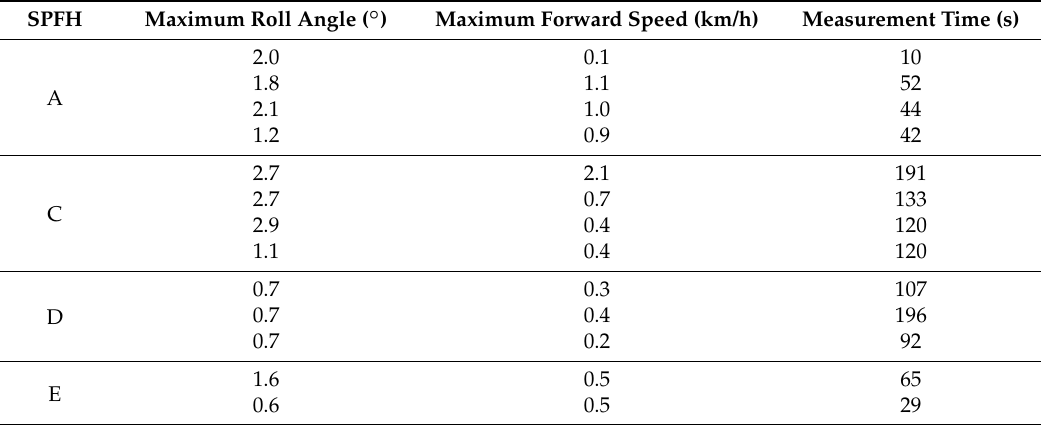
Table 5. The measured roll angle of the tested SPFH during fruit picking and